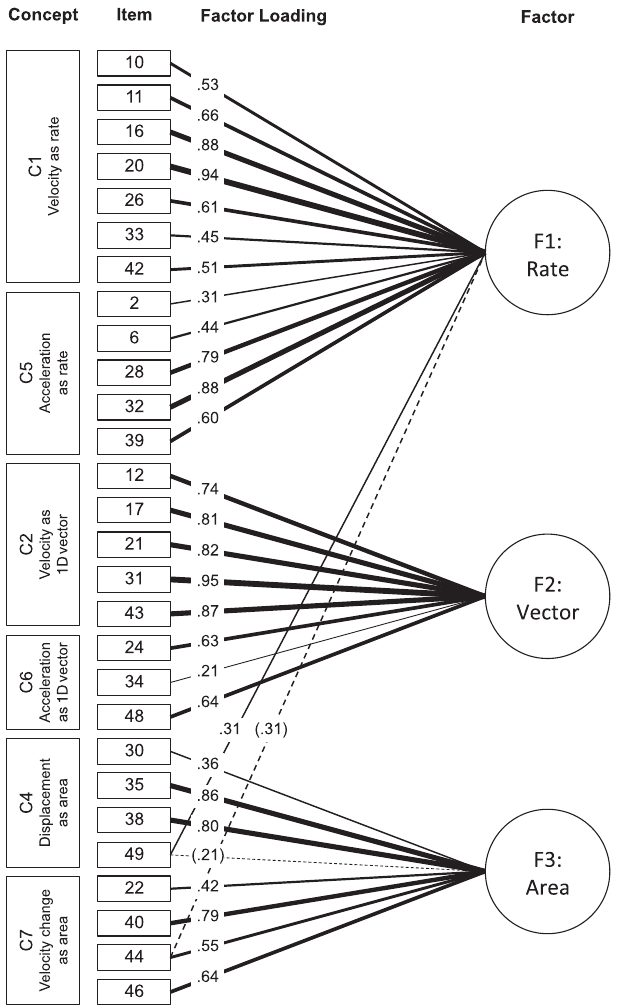
FIG. 3. Factor loadings of the graph items on three factors. The left side shows the assignment of the items to the corresponding concepts. The EFA was conducted with PAF. For clarity, only loadings above 0.20 are shown in the figure. Loadings above 0.30 are commonly considered to be significant. The solid lines mark the highest loadings of the individual items. Lower loadings are indicated with dotted lines.